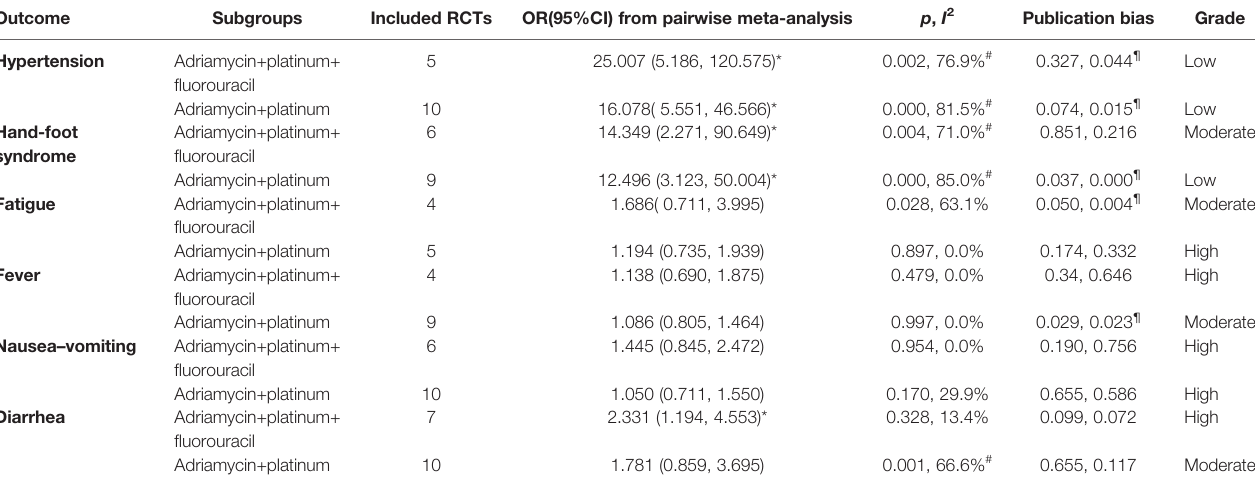
TABLE 4 | Safety of TACE+apatinib versus TACE in adverse effect, which was analyzed by classi fi cation of TACE agents. Outcome Subgroups Included